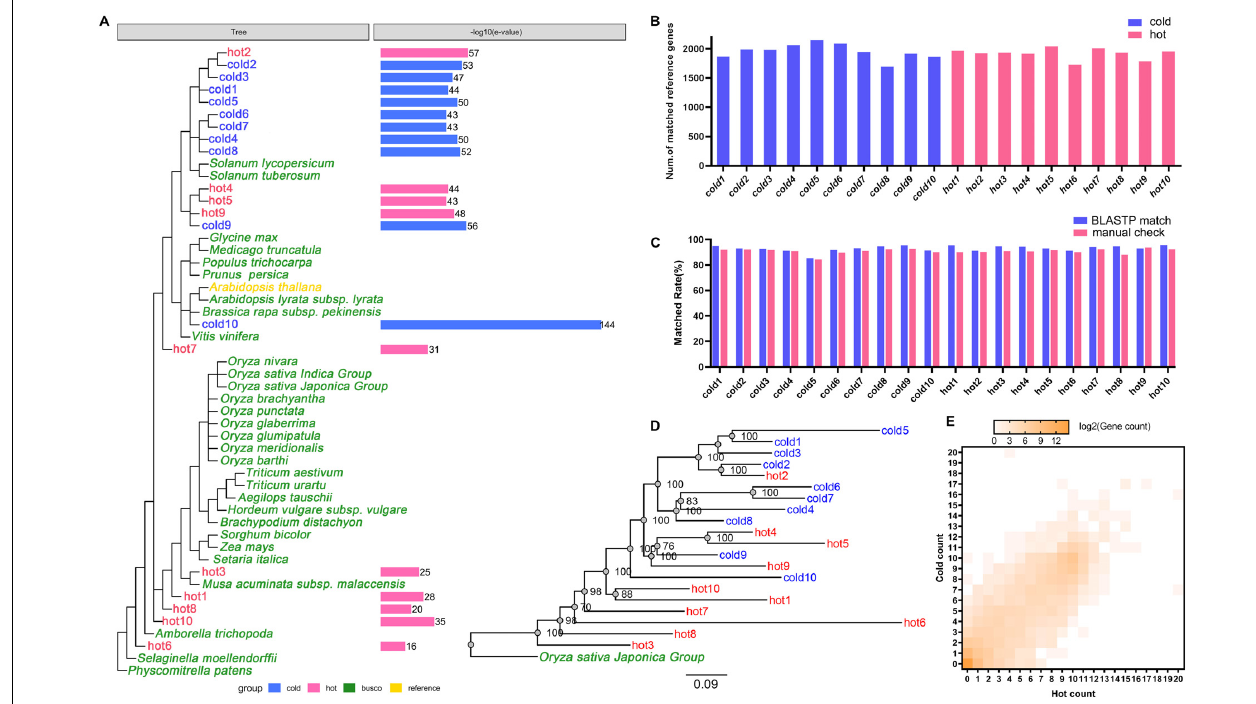
FIGURE 4 | Cross-species annotation of expressed genes in 20 species. Red color indicates HMs with the hot property, blue color indicates HMs with the cold property, yellow color indicates reference species, and green color indicates 31 plants from 1,440 BUSCO sets. (A) E -value cutoff parameters of 20 samples in BLASTP. The phylogenetic tree showed the relationships of 20 HMs samples, the reference, and 31 plants from BUSCO. The column graphs on the right side showed the E -value cutoff which had been converted to –log10( E -value). (B) Read alignment counts of 20 samples. The difference of alignment counts was not statistically significant ( P > 0.05). (C) Coincidence rates of the annotation results between using Arabidopsis thaliana as the reference and using Oryza sativa as the reference. Blue color indicates the coincidence rates were obtained by using BLASTP match; red color indicates the coincidence rates were obtained by manual comparison. (D) The maximum likelihood phylogenetic tree of 20 HMs and O. sativa constructed by concatenating the sequences of conserved genes. The numbers on the branches were the consistent quantities derived from bootstrap analysis. (E) The heat map of reference gene numbers according to the numbers of species genes (axis X -/ Y -) in each group which matched to the reference genes. The color key from gray to brown indicates small to large matched gene numbers.